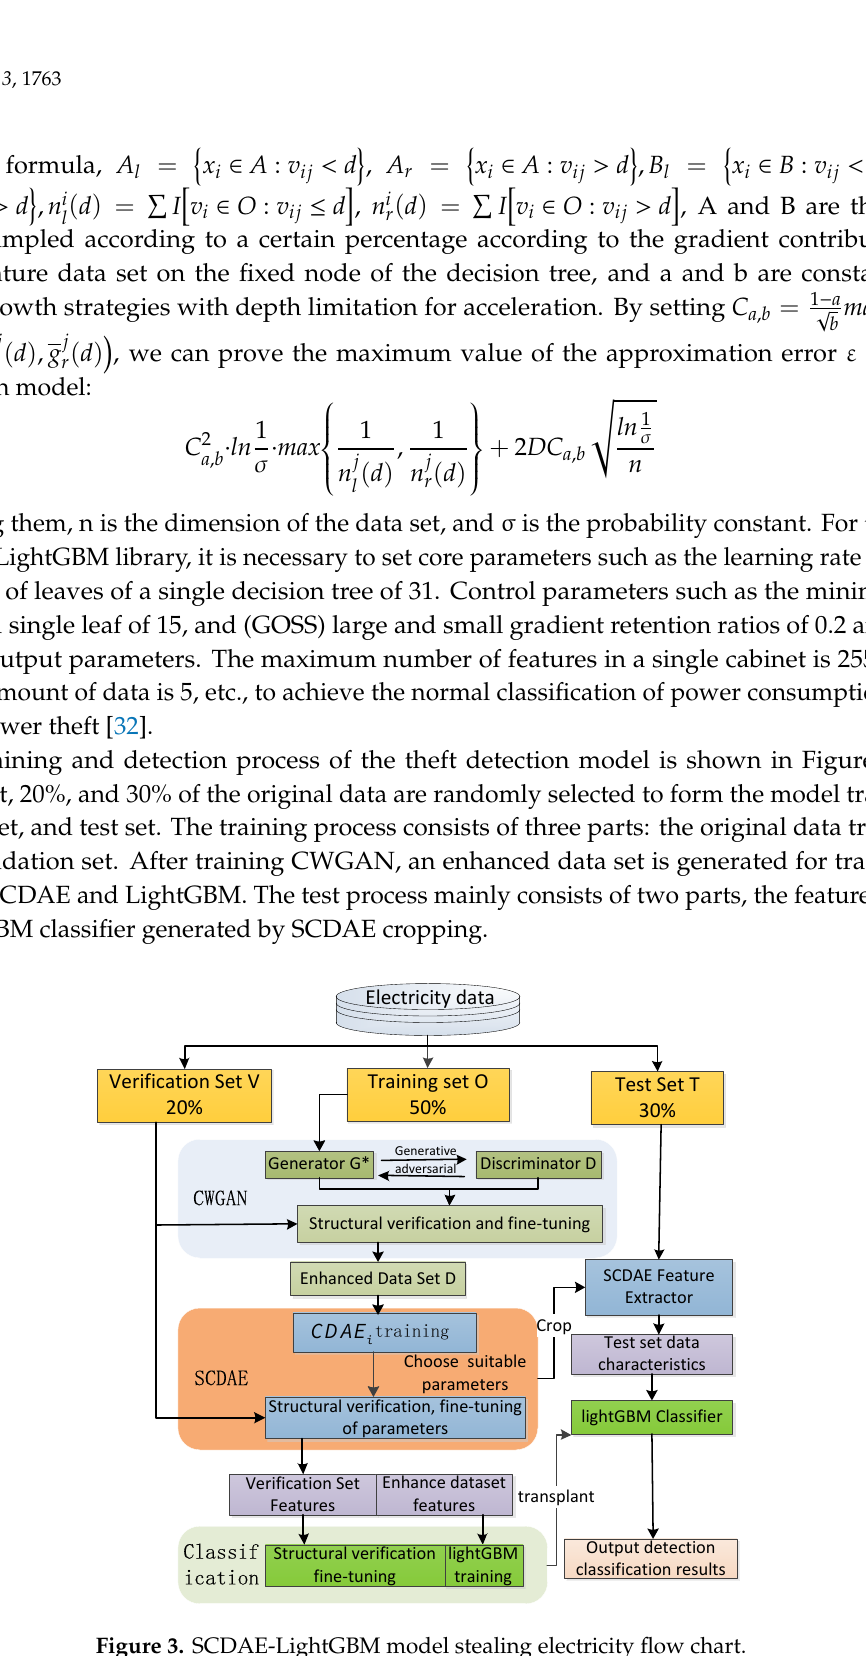
Figure 3. SCDAE-LightGBM model stealing electricity flow chart.